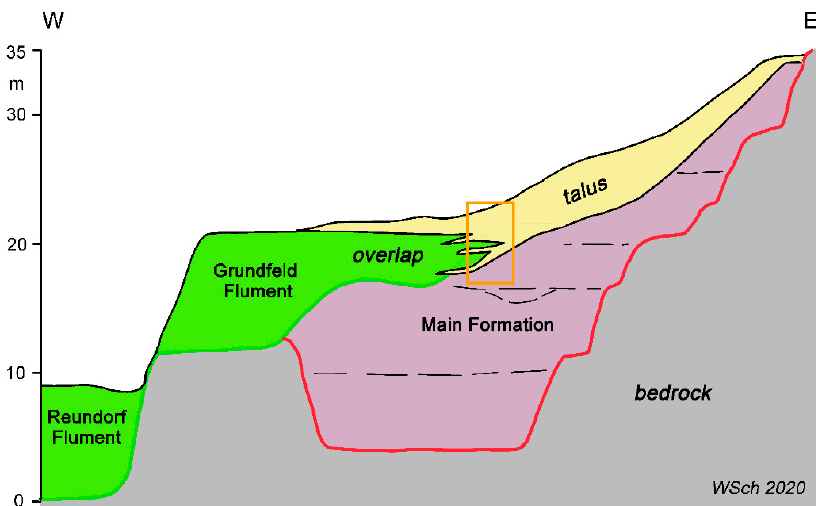
Figure 13. Scheme of the valley’s shift from east to west: Red line: Pelma of the eastern valley filled by the Main Formation. Green: Fluments of the western valley with overlap of the Grundfeld Flument over the truncated eastern valley filled by the Main Formation. Brown rectangle: Detail of the overlap situation in the Grundfeld gravel pit in Figure 14.